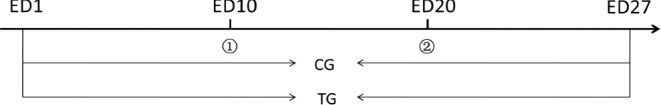
The basic treatment process. CG, TG mean control group and treatment group. Treatment was comprised of increasing the incubation temperature by 1°C during ED1–10, ED10–20, ED20–27. means at ED10, more than 15 qualified eggs were transferred from control group to treatment group and incubated at 38.8°C during ED10–20, while eggs in control group still incubated at 37.8°C. means at ED20, more than 15 qualified eggs were transferred from control group to treatment group and incubated at 38.8°C during ED20–27, while eggs in control group still incubated at 37.8°C. Samples were taken at ED10, 20 and 27.